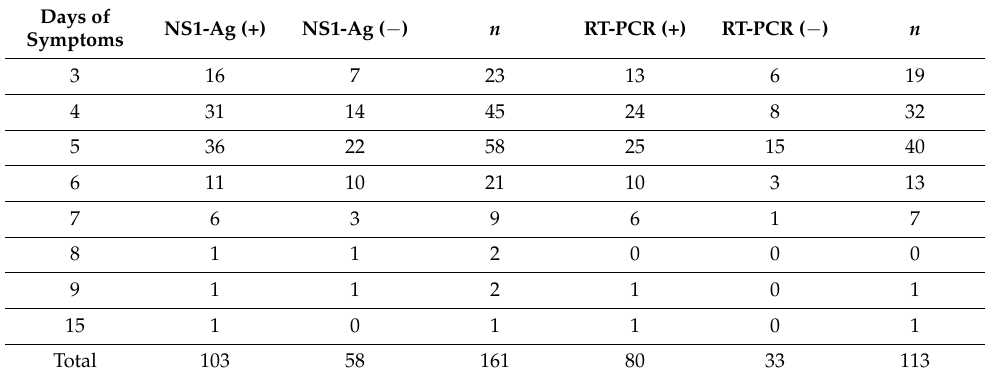
Table 4. Dengue diagnostic tests results by days of symptoms.